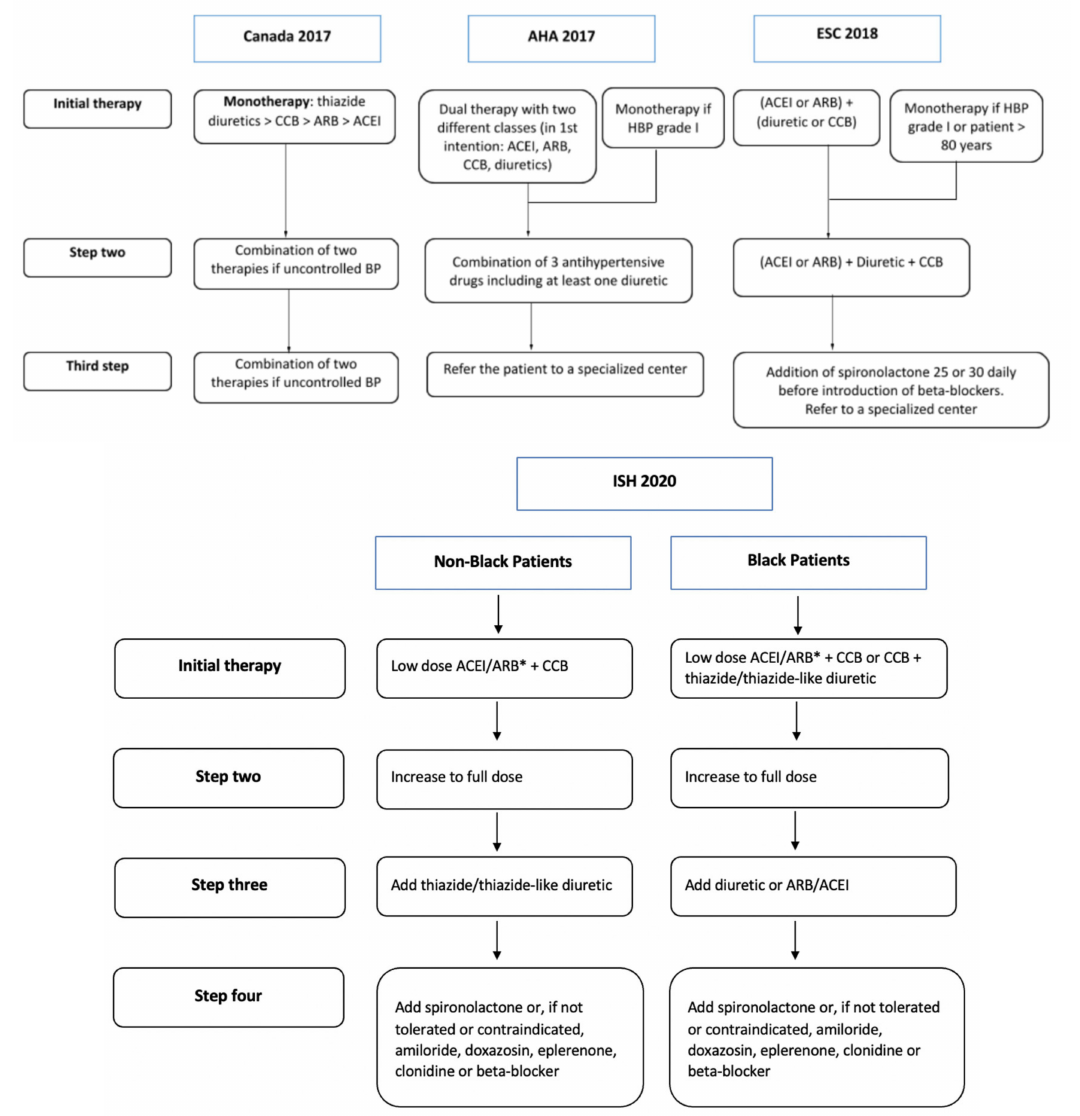
Figure 1. Therapeutic schedule for a patient with essential hypertension without other risk factors. * No ACEI/ARB in women with or planning